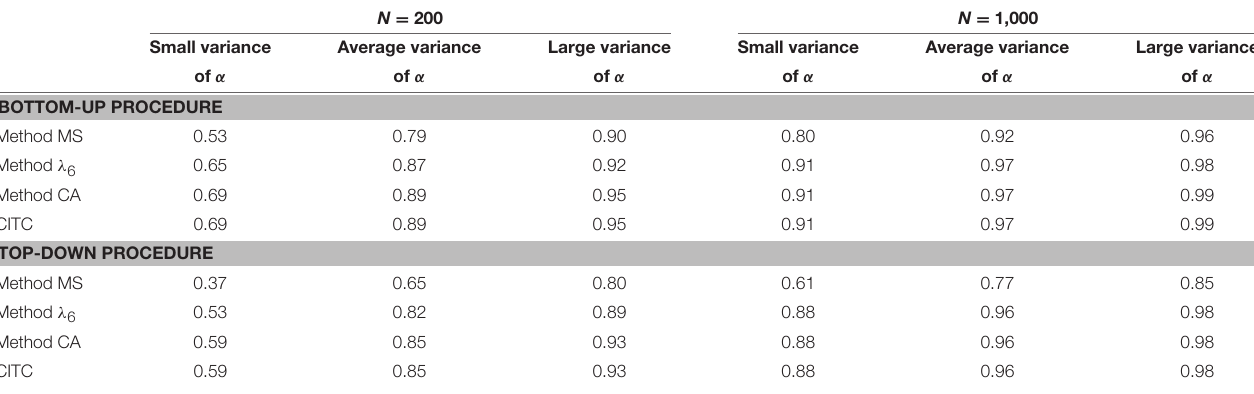
TABLE 5 | Kendall’s W for 1,000 replications between the ordering based on the population test-score reliability and the ordering produced by the three item-score reliability methods and the corrected item-total correlation (CITC), for the bottom-up and the top-down procedure in the six different conditions. N = 200 N = 1,000 Small variance Average variance Large variance Small variance Average variance Large variance of α of α of α of α of α of